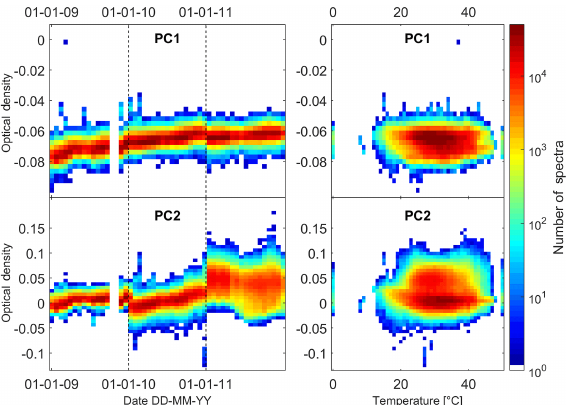
Figure D2. Peak-to-peak apparent optical density (e.g. peak-to-peak optical depth of the principal component times the fit coefficient) of the first and second principal components for instrument D2J2140 at Tungurahua. The vertical dashed lines indicate the start of new time intervals for which a new set of principal components was